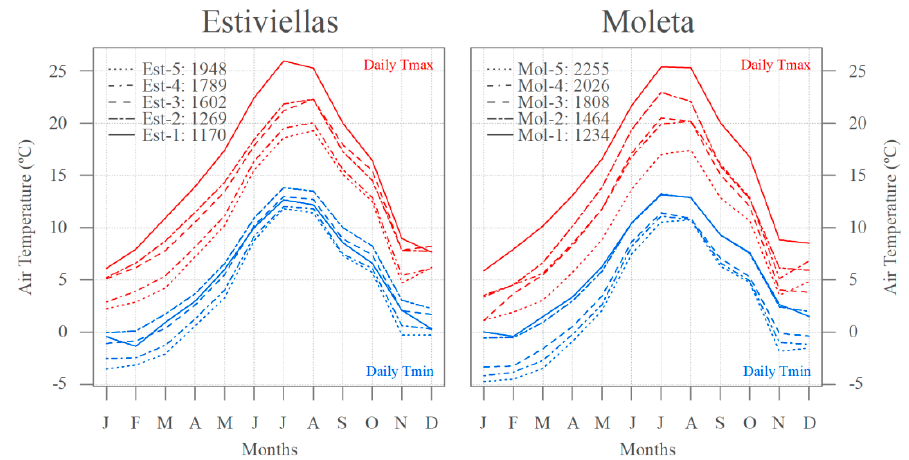
Figure 4. Monthly means of daily maximum ( Tmax , red lines) and minimum ( Tmin , blue lines) air temperatures for the ten locations during the study period.